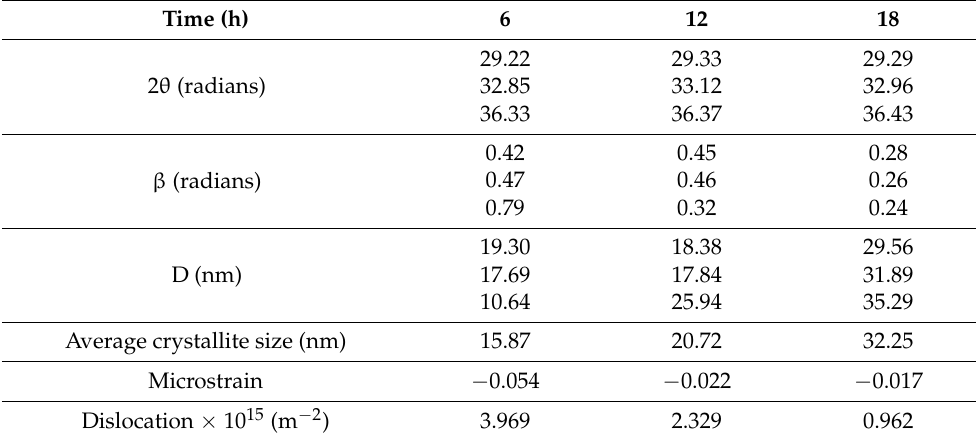
Table 1. Calculated lattice parameters for ZnMn 2 O 4 spinel samples. Time